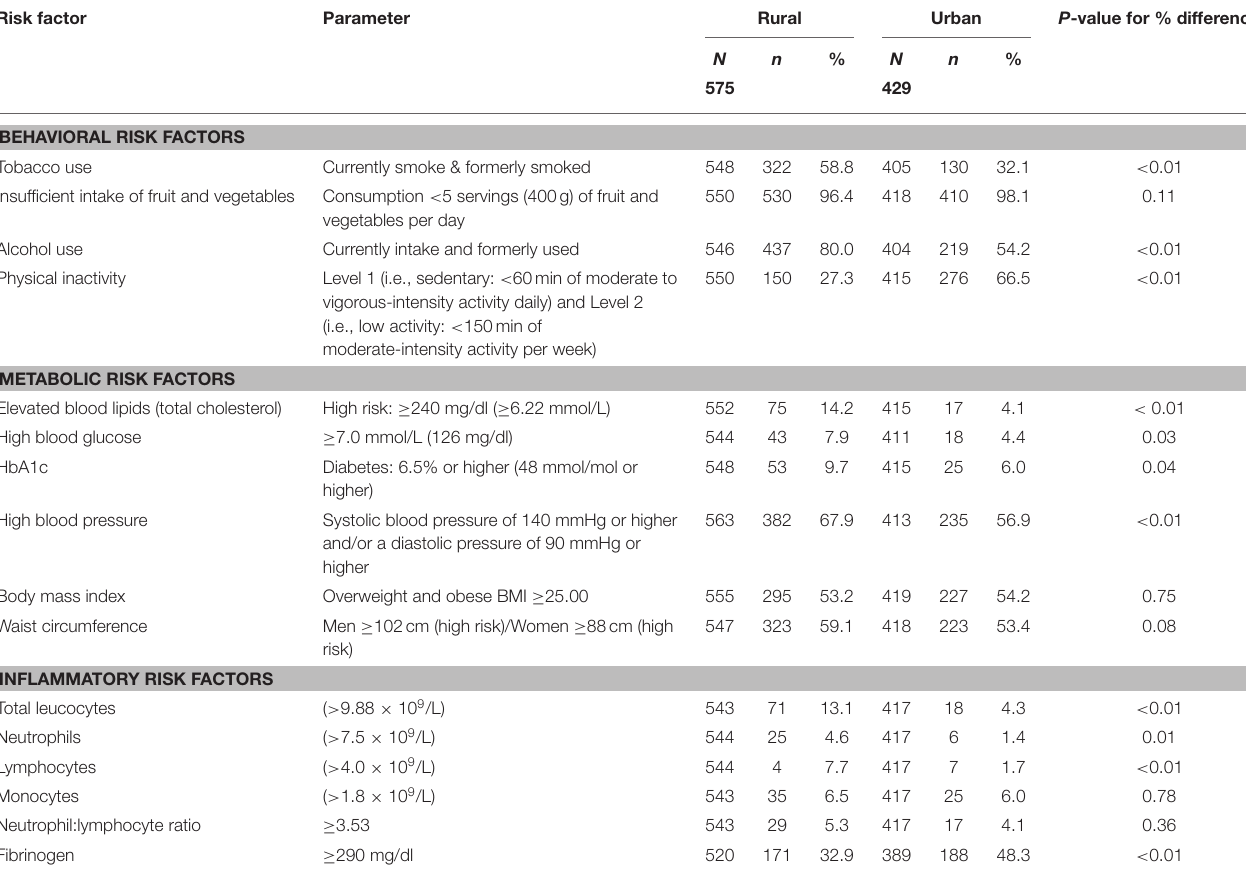
TABLE 2 | Summary of behavioral, metabolic and inflammatory risk factors of rural and urban participants. Risk factor Parameter Rural